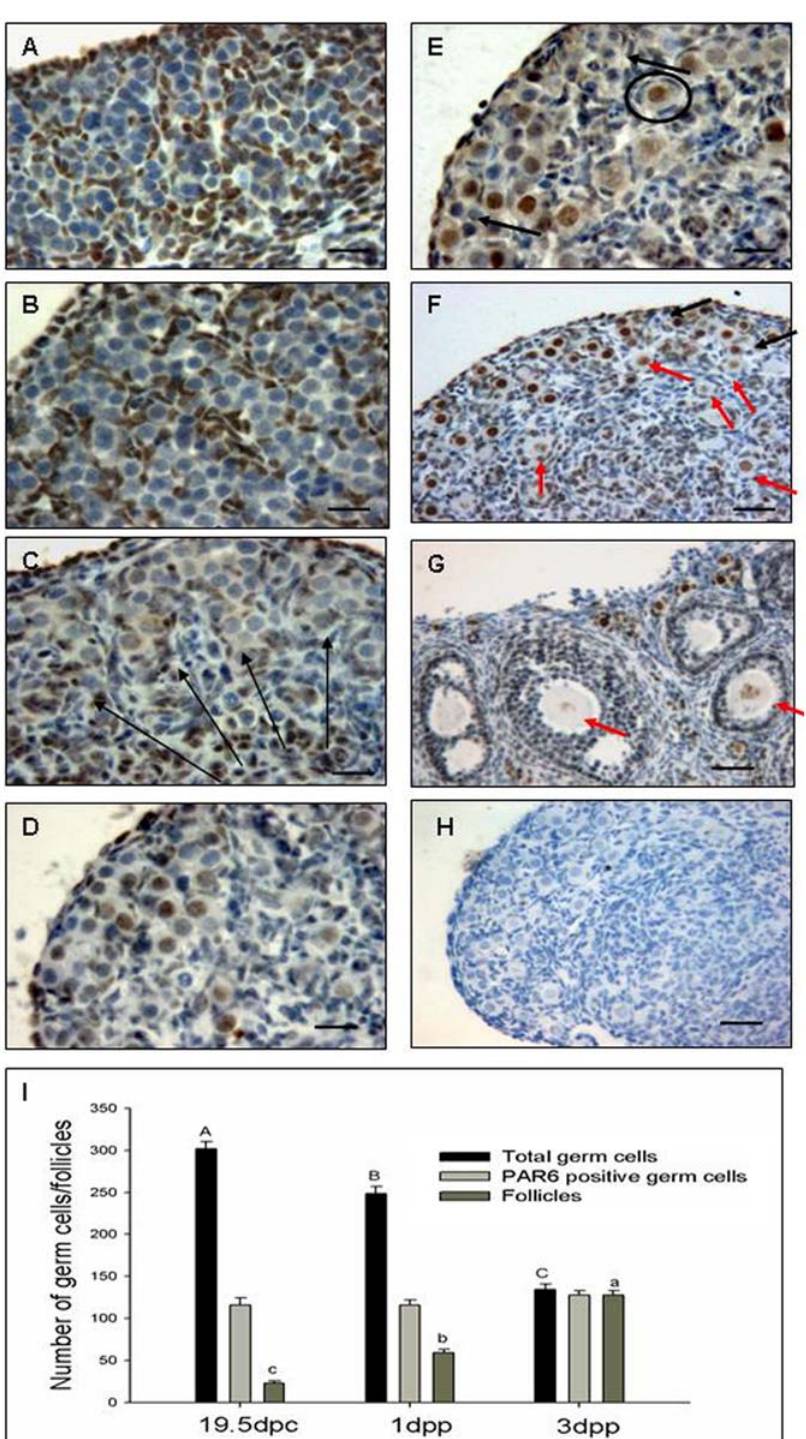
Figure 1. Immunohistochemical localization of PAR6 in the mouse ovary. The germ cells with the cyst structure in the 13.5 dpc (A) and 15.5 dpc (B) fetal ovaries did not show positive staining for PAR6 in contrast to the strong staining in somatic cells. At 17.5 dpc, the germ cells moved to the cortex (long arrow), and their cytoplasm began to express PAR6 (C). After 19.5 dpc, PAR6 staining was strong in the nuclei of some germ cells (D, 19.5 dpc; E, 1 dpp) and almost all oocytes in primordial follicles, while the oocytes nuclei of growing follicles showed weak expression of PAR6 (F, 3 dpp; G, 8 weeks). No reaction was observed in control sections (3 dpp) after replacement of the anti-PAR6 antibody with nonimmune serum (H). Black arrow, small or shrunk germ cell; red arrow, growing follicle; ring, primordial follicle. A–E, Bar=20 m m; F–H, Bar=40 m m. The numbers of germ cells, PAR6 positive germ cells and follicles in the largest cross-section of the ovary with different stages (I). Each independent data came from six ovaries. Different superscripts denote differences (P , 0.05) in the total germ cells or follicles, respectively.